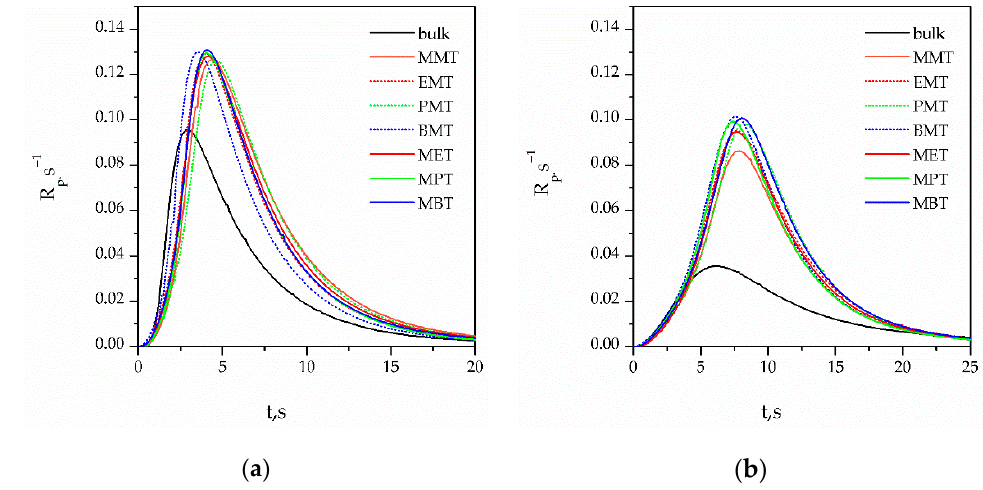
Figure 6. Kinetics curves of photopolymerization of thiol–ene systems ( a ) PETMP+TATT and ( b ) PETMB+TATT in a mixture of 1,4-dialkyl-1,2,4-triazolium ionic liquids with propylene car- bonate. Solid line—systems with 1-methyl-4-alkyl-1,2,4-triazolium IL; dashed line—systems with 1-alkyl-4-methyl-1,2,4-triazolium